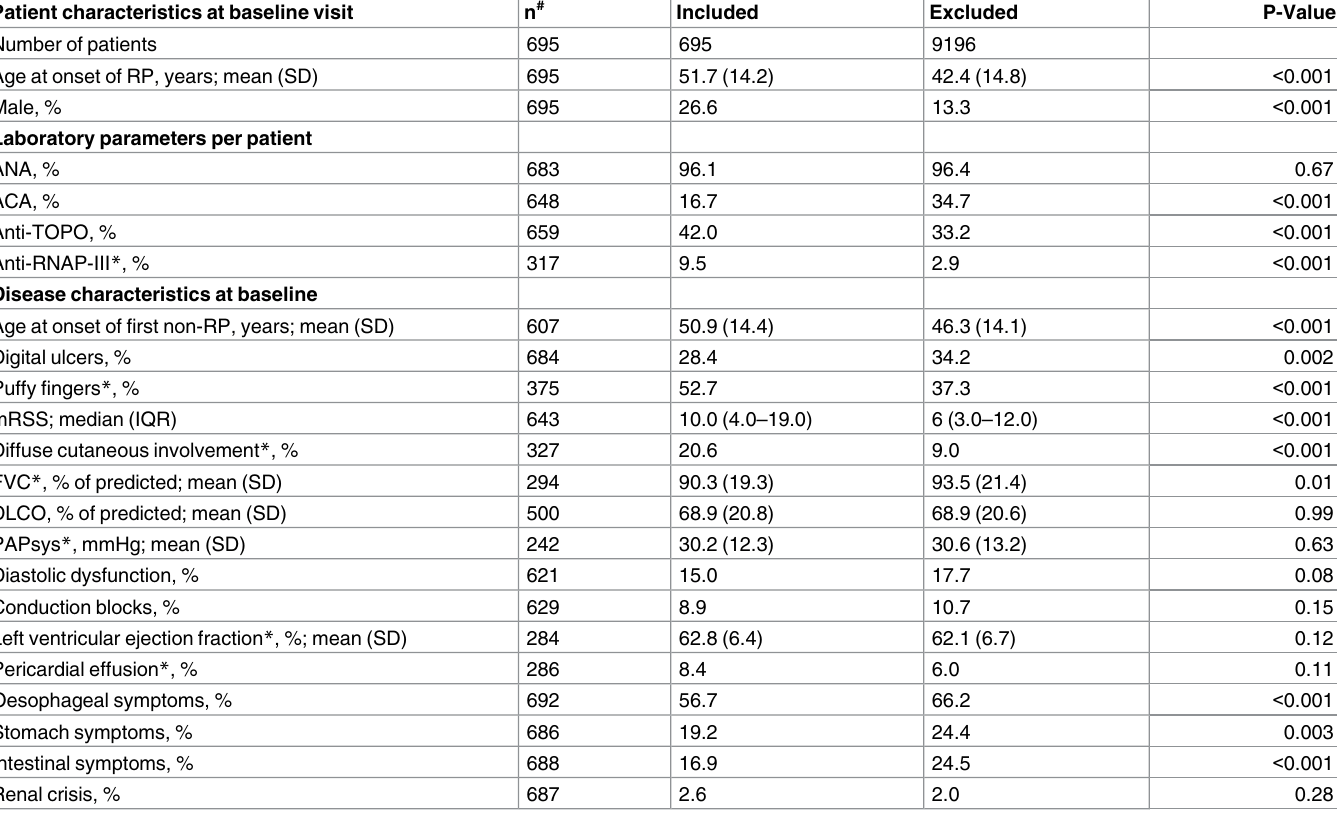
Table 2. Comparison of disease characteristics at the baseline visit between patients included in this analysis (visit within 1 year after onset of RP, study population ) and those excluded (no visit within 1 year after onset of RP). ACA, anti-centromere autoantibodies; ANA, anti-nuclearautoanti- bodies; anti-RNAP-III, anti-RNA-polymerase-III autoantibodies; anti-TOPO, anti-topoisomerase-I autoantibodies; DLCO, single breath diffusing capacity for monoxide;FVC, forced vital capacity; IQR, interquartilerange; mRSS, modified Rodnanskin score; PAPsys, systolic pulmonary artery pressure as esti- mated by echocardiography; RP, Raynaud’sphenomenon; SD, standard